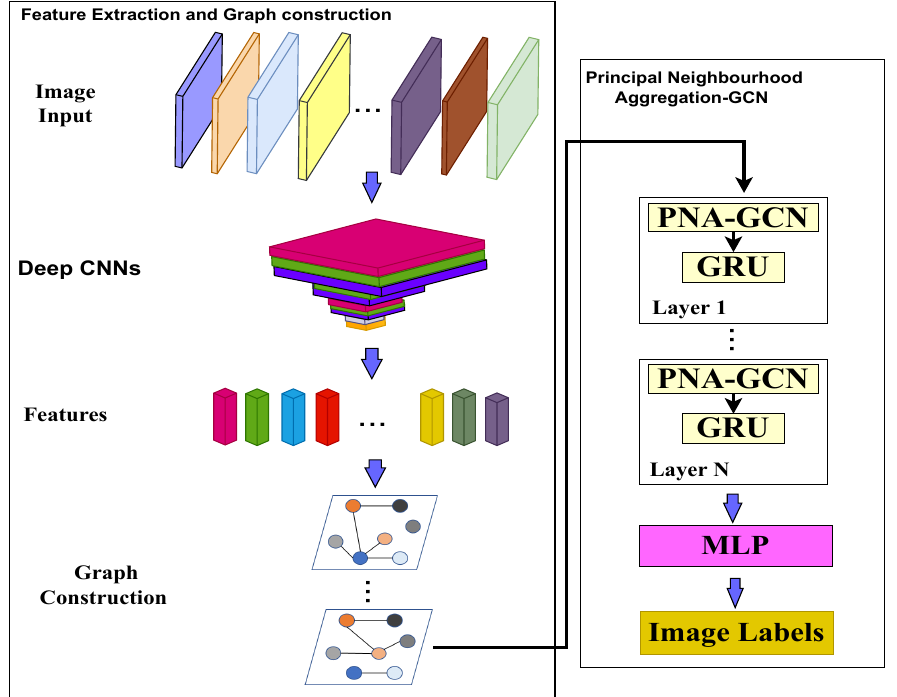
Figure 5. The overall architecture of the proposed model. In the architecture, we first use deep CNNs to extract the image vector features. Then, we construct graphs by calculating the distances between image vector features. Next is multiple principal neighborhood aggregation GCN. Each PNA-GCN is followed by a GRU layer. Finally, a MLP is used to classify features and images are